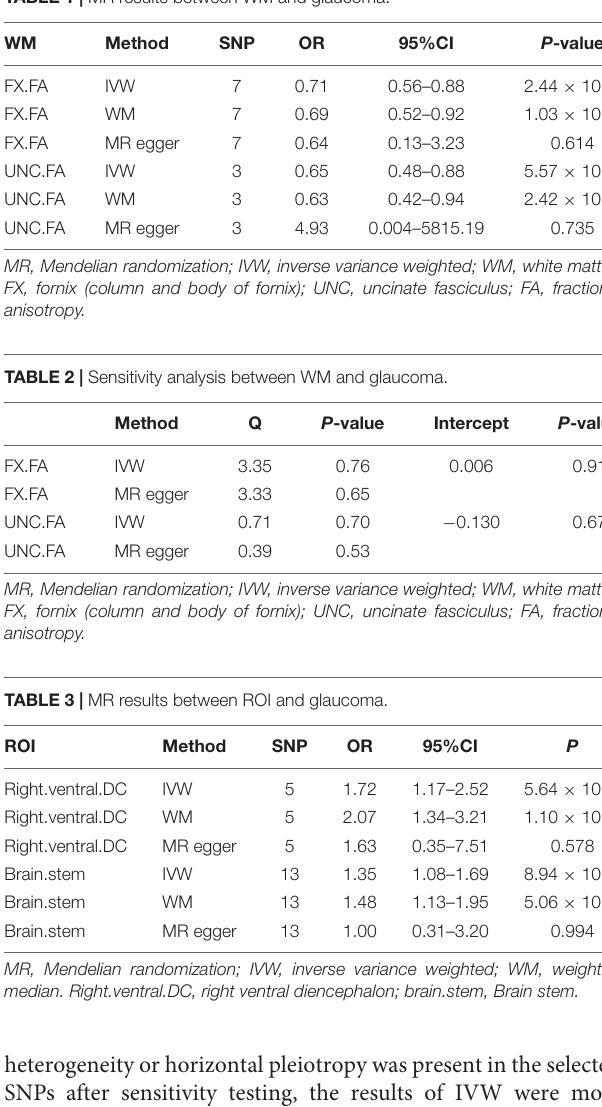
TABLE 1 | MR results between WM and glaucoma.